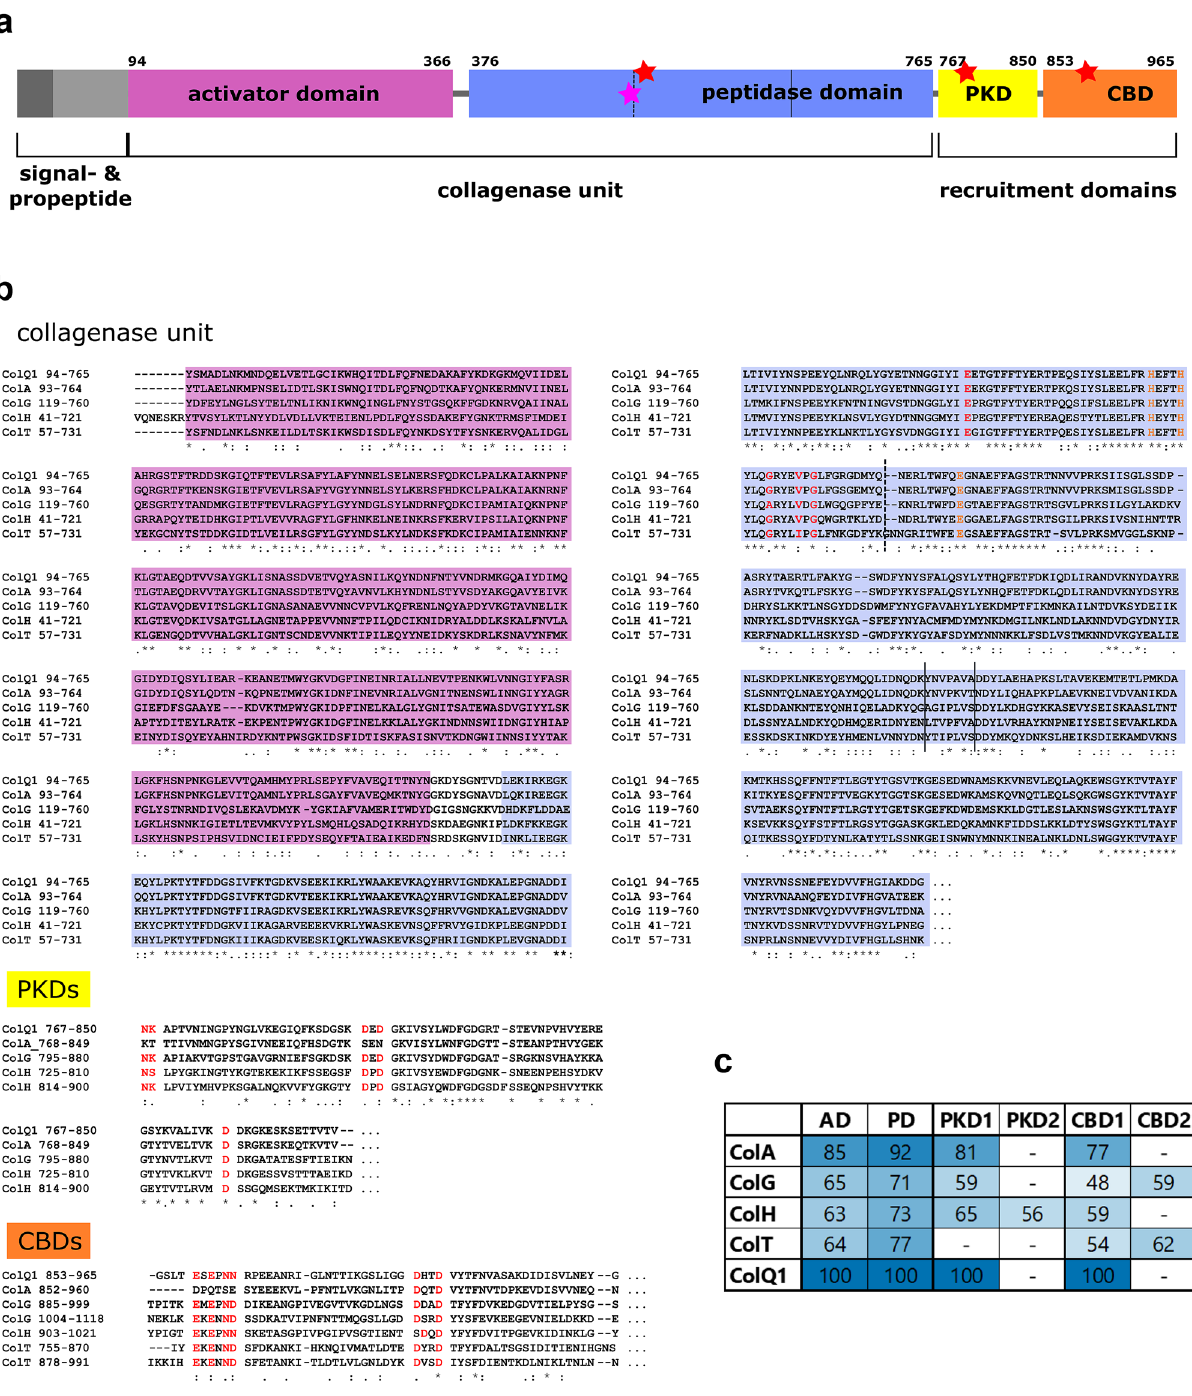
Figure 1. Bioinformatic analysis of ColQ1 ( a ) Schematic domain architecture of ColQ1 based on sequence homology to microbial collagenases and conserved domain predictions 54,55 . Pink star indicates the zinc-binding site and red stars indicate the conserved calcium-binding sites. ( b ) Multiple alignment of mature sequences of ColQ1 (B9J3S4) from B. cereus strain Q1, ColA (Q81BJ6) from B. cereus strain ATCC 14579, ColG (Q9X721) and ColH (Q46085) from C. histolyticum and ColT (Q899Y1) from C. tetani. Magenta, light blue, orange and red are the activator domain, peptidase domain, zinc-binding residues and calcium-binding residues 73,74 , respectively. Division of the peptidase domain into the catalytic and the helper subdomain is indicated by solid lines. Division of the catalytic domain into the upper and lower half-domain is indicated by a dotted line in (a) and (b). The alignment was aided by Clustal Omega 75 . ( c ) Similarity [%] of the activator (AD), peptidase (PD), polycystic kidney disease like (PKD) and collagen-binding domains (CBD) of ColA, G, H and T to the corresponding domains in ColQ1. Darker blue indicates higher similarity. Calculated by BLASTp 56